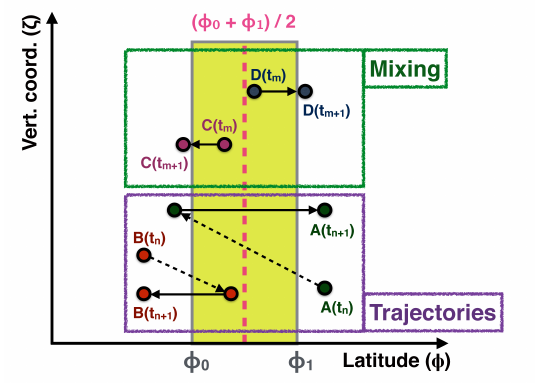
Figure 1. A schematic of the implementation of transport barriers in the CLaMS model into the trajectory and mixing modules respec- tively. The x axis represents latitude and the y axis is the vertical coordinate. The barrier is shown in light-green colour, between φ 0 and φ 1 latitudes. The capital letters A, B, C and D represent the cross-barrier movements of different air parcels between time steps t n and t n + 1 for the trajectory module, and t m and t m + 1 for the mix- ing